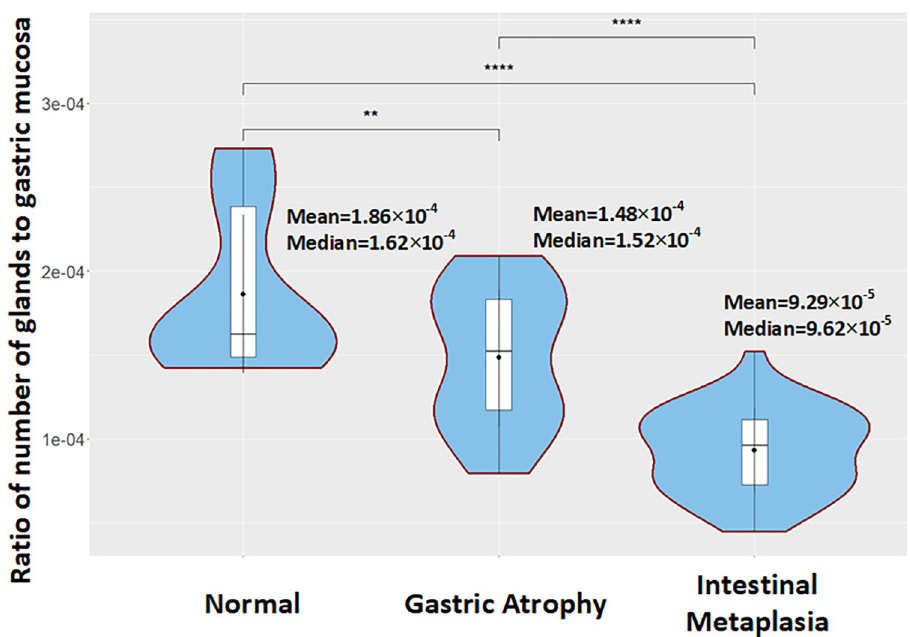
Fig 9. Box plots comparing the ratio of number of glands to gastric mucosa between normal, Gastric Atrophy (GA) and Intestinal Metaplasia (IM) cases included in the GAGL dataset.